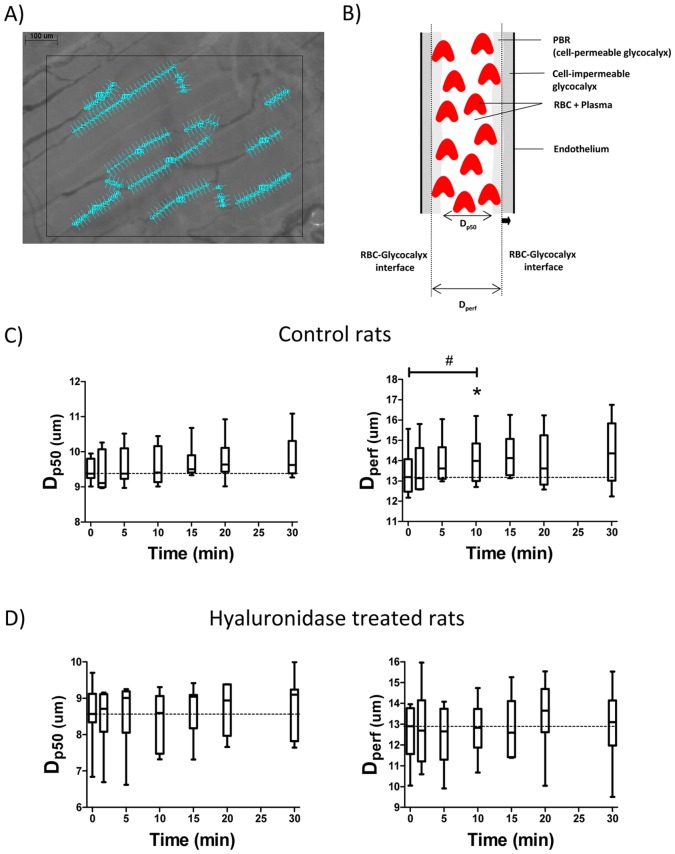
Example of a single SDF image of rat gastrocnemius microcirculation is shown in panel A.From each movie (total length: 40 frames) recorded by the SDF camera the distribution of the width of the red blood cell (RBC) column in each microvessel that fitted the criteria of the analysis (a) in focus, b) had a sufficient length and were not close to bifurcations, and c) were continuously filled with RBCs and did not contain plasma gaps) was determined along the vessel by placement of lines ± every 10 µm perpendicular to the vessel direction (as shown by numbered lines in image), and calculating the full width at half maximum of the intensity profile 10 times in front and 10 times behind each line frame by frame in all 40 consecutive frames (see methods). Per vessel, the DP50 and Dperf, by linear extrapolation of the distribution of RBC column width, were determined, revealing the perfused boundary region (PBR), which includes the cell-permeable part of the glycocalyx (see Discussion, page 16). Between the PBR and the endothelium the cell-impermeable glycocalyx resides. An increase in the accessibility of this part of the glycocalyx for the flowing RBCs is associated with an outward movement of the RBC-glycocalyx interface as shown by the thick arrow in panel B. Effects of insulin on the Dp50 and Dperf in control rats (n = 6) are shown in panel C and effect of insulin on the Dp50 and DPerf in hyaluronidase treated rats (n = 7) are shown in panel D. #, P<0.05 (1-way ANOVA), *, P<0.05 versus baseline (t = 0) (Tukey’s post hoc test).